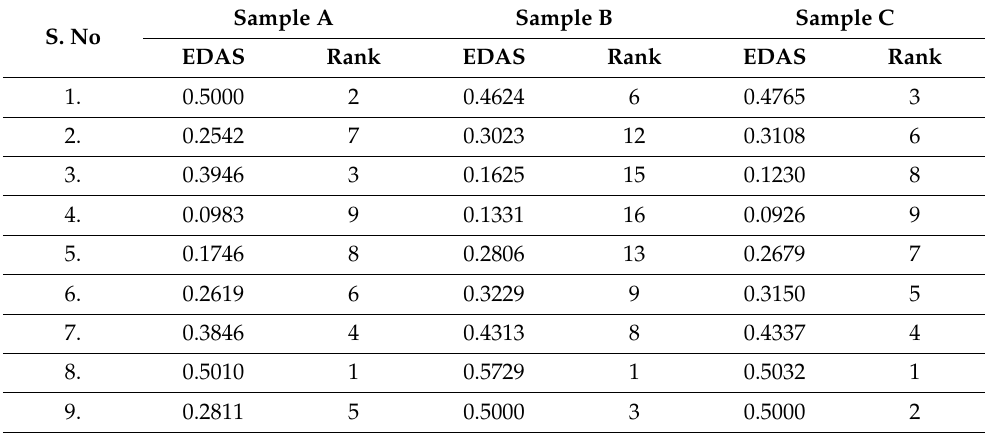
Table 3. EDAS Ranking.